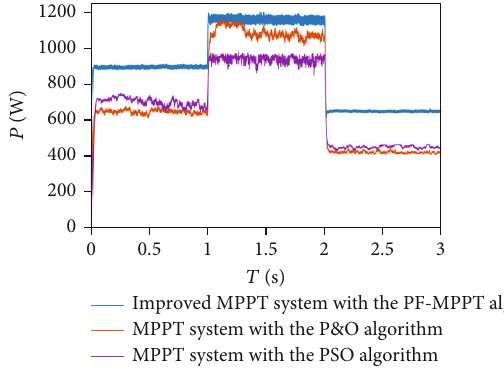
Figure 19: Simulation results of output